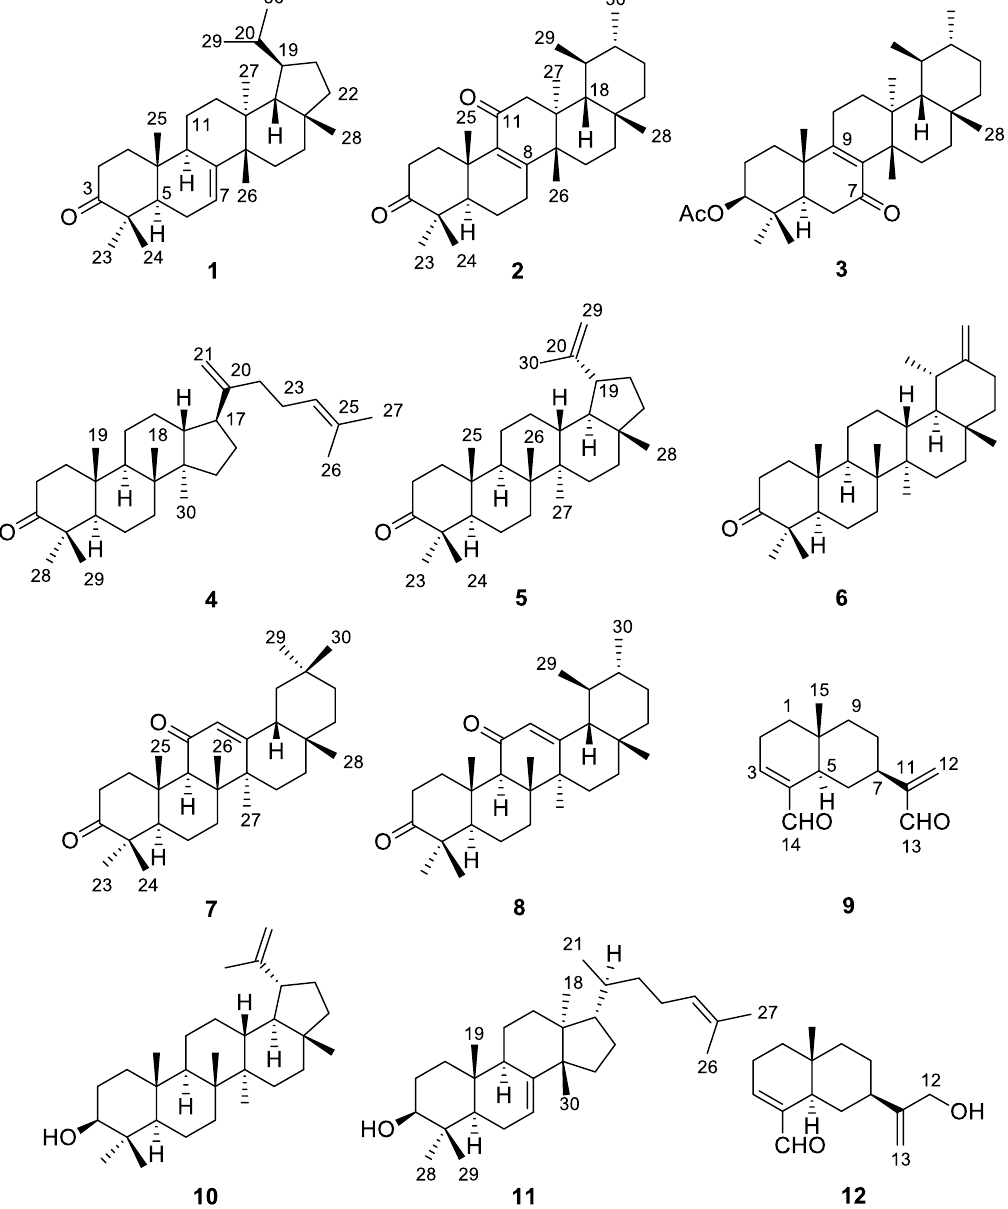
Figure 1. Chemical structures of compounds 1 – 12 from L. acanthoclada .